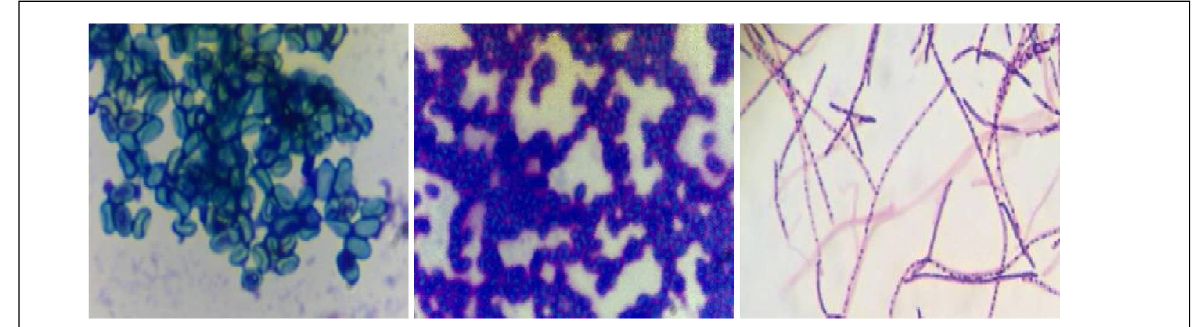
Figure 3b: Microscopic images of the isolates C13, C14, C16 grown on solid medium as seen under a compound microscope at x400